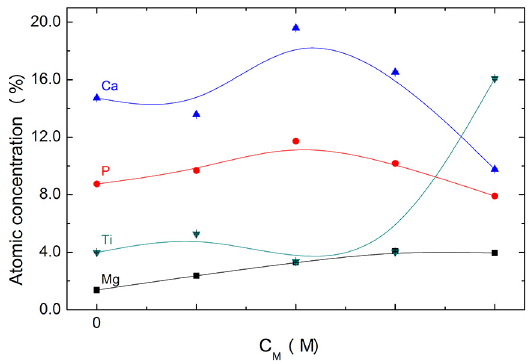
Figure 8. Atomic proportions determined by EDS in the bulk of . samples treated with different C Figure 10. Phases proportion calculated by Rietveld refinement M of samples treated by PEO as a function of C for: H - Hydroxyapatite, R - Rutile, M - Magnesium phosphide, to observe that the treatments resulted in the formation of and A - anatase, rutile, crystalline calcium phosphate, magnesium phosphides, and hydroxyapatite. The diffractograms also reveal the modification of the crystalline structure of the coatings as the proportion of magnesium acetate is increased. It is possible to conclude that the higher C , the smaller the M peaks related to hydroxyapatite as becomes evident if one notes that diffractogram of the coating grown with C = M 0.08 M contains only the peaks produced by anatase, rutile and metallic titanium.